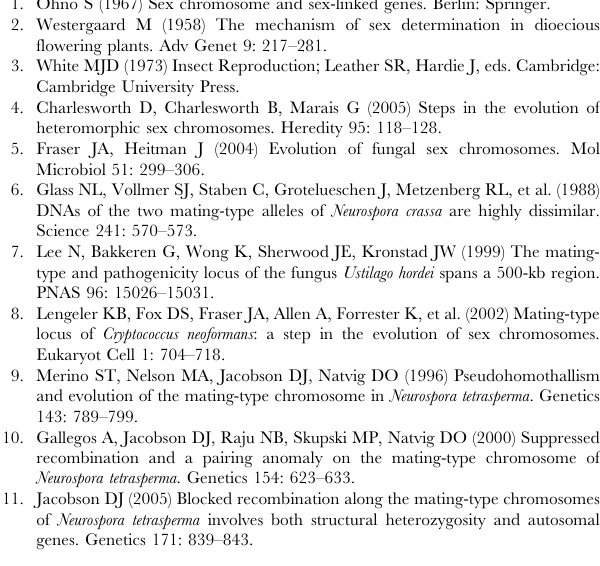
Table S2 Primer Sequences, Annealing Temperatures, and Genomic Locations of Genes According to Gene Order in N.